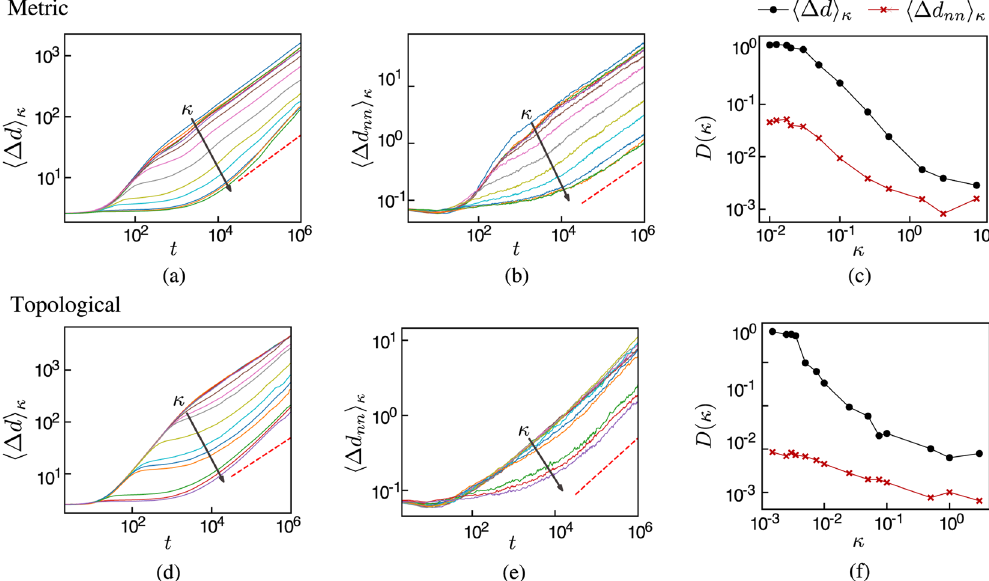
Figure 4. Average distance between particles 〈 Δ d 〉 κ and to the nearest neighbor 〈 Δ d nn 〉 κ as functions of time for different values of the average long-range connectivity κ . The short-range interactions were implemented metrically for the top panels, and topologically for the bottom panels. The arrows indicate the direction of increasing κ in the interval [0.0, 9.0] for metric short-range interactions and in the interval [0.0, 1.0] for topological ones. Note that these average distances asymptotically behave as t α (the red dashed line corresponds to α = 1/2), indicating diffusive behavior. The two panels at the right show the diffusion coefficient as a function of κ . As κ increases, the diffusion coefficient decreases several orders of magnitude, showing the effect of